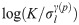
The compensated turbulent pair diffusion coefficient, log(K/σlγ(p)), against log(σl/η), for Rk = 102 for the same cases as in Fig 6, and with the same colour coding.For clarity some of the plots have been spaced out vertically, hence no scale is shown on the ordinate; this does not affect the scalings.